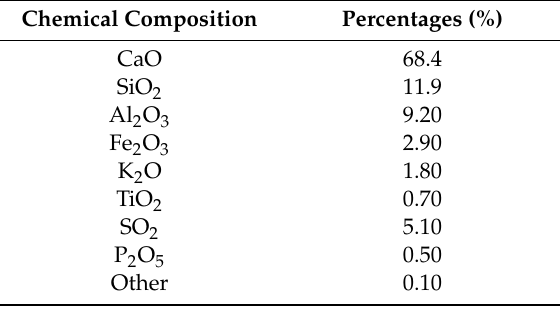
Table 1. Composition of high-early-strength cement analyzed using X-ray fluorescence